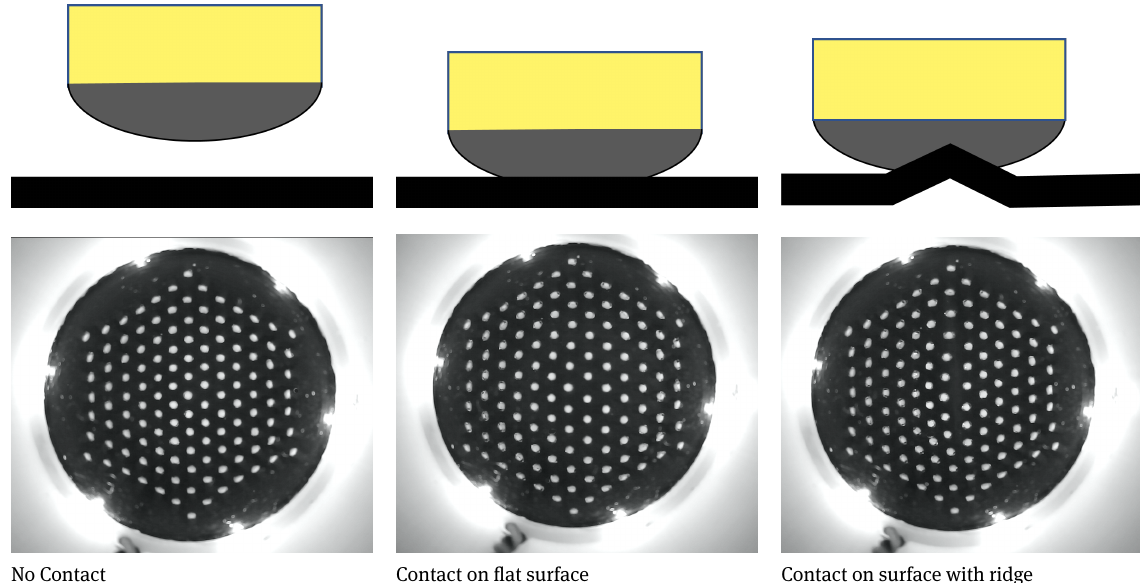
Contact on surface with ridge